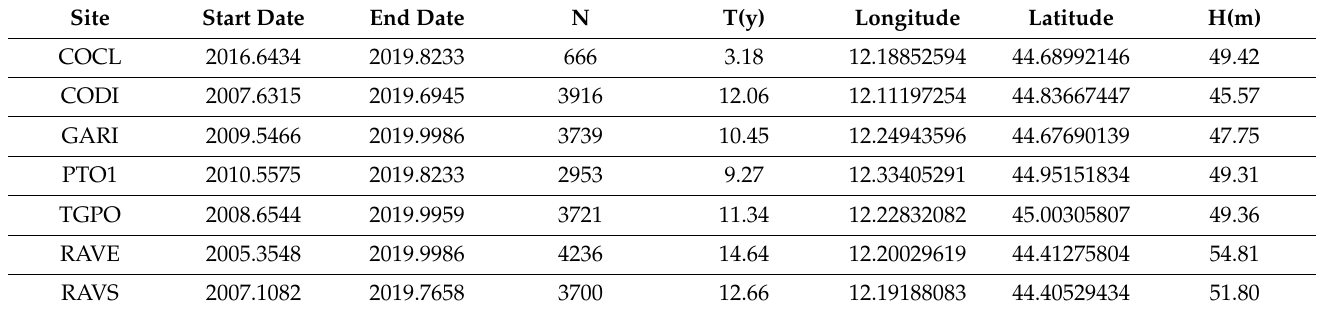
Table 1. GNSS permanent sites used in this study, including: start/end dates of first and last observation (decimal year); number of effective observations (N); observation time-interval